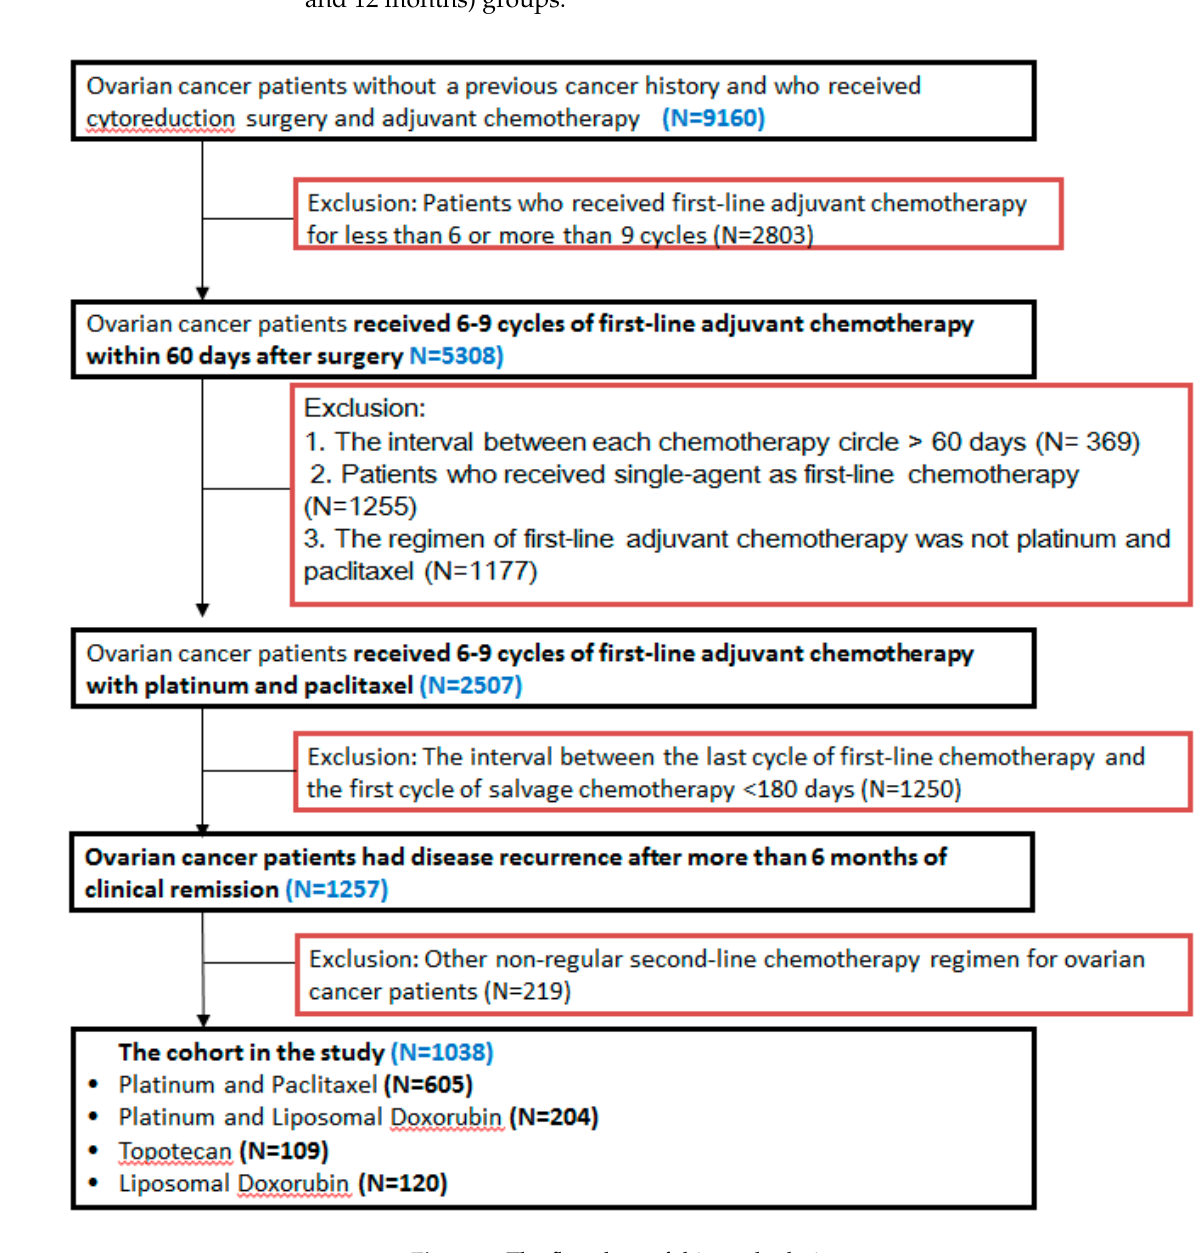
Figure 1. The flowchart of this study design.